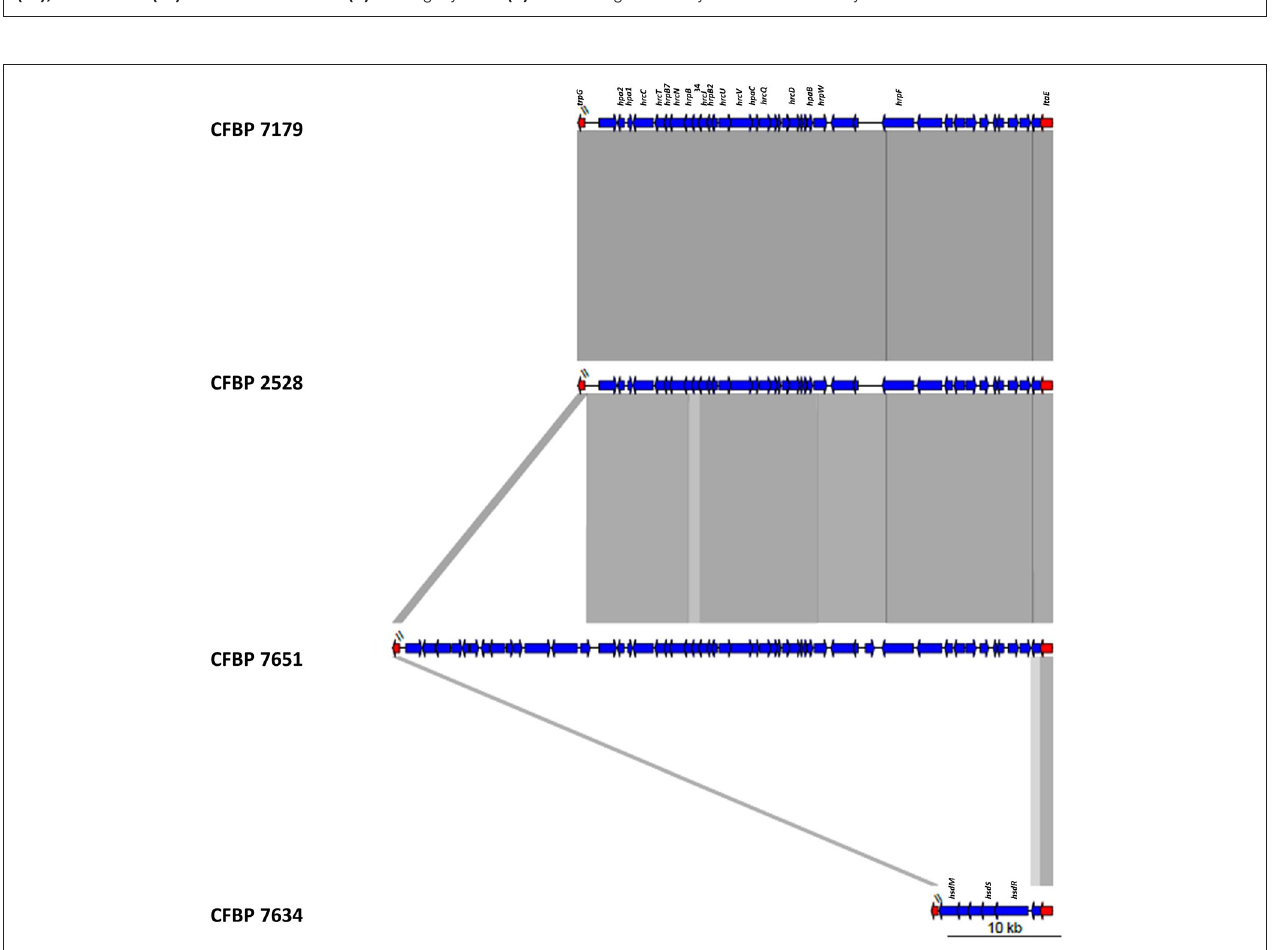
BLASTX hits with dehydrogenase and epimerase implicated in cell envelope biogenesis, two transcription regulators and a sodium/dicarboxylate